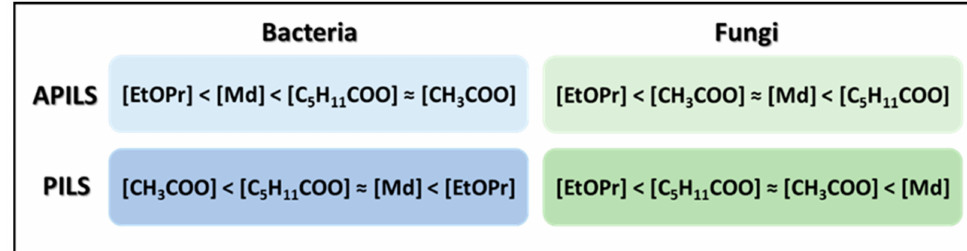
Figure 6. The anion effect on PILs and APILs against bacteria and fungi